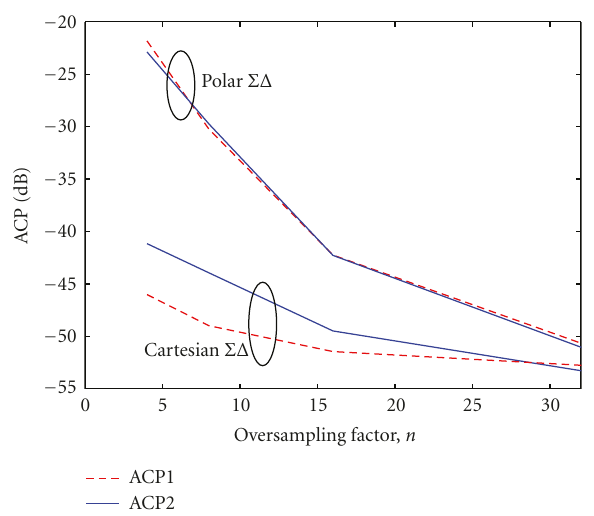
Figure 14: Plot of ACP (dB) against oversampling rate, n . The first and second adjacent channels are